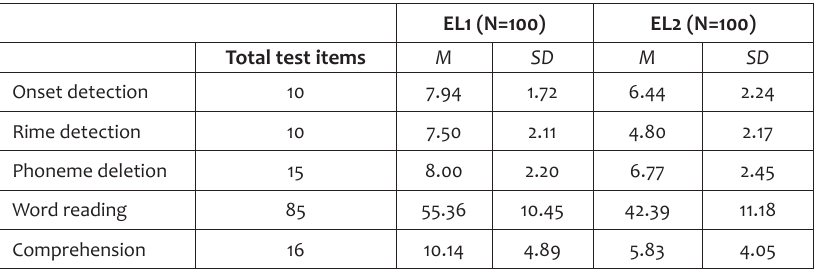
Table 1: Performance of EL1 the EL2 learners on the phonological awareness and reading